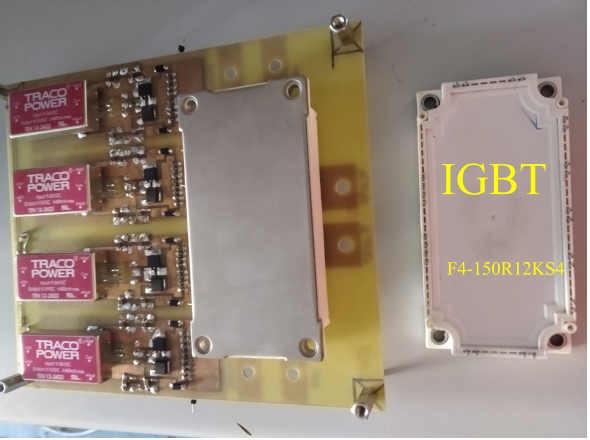
Figure 15. Illustration of the driver